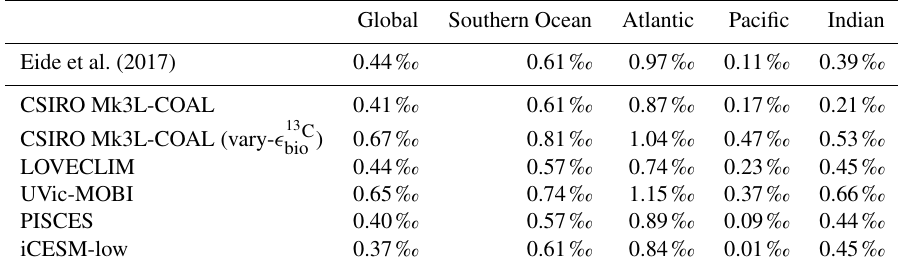
Table 2. Comparison of global and region mean δ 13 C DIC between observations (Eide et al., 2017) and model simulations. Means are annual averages and do not include the Arctic or the upper 200m of the water column. All data were regridded onto the CSIRO Mk3L-COAL grid